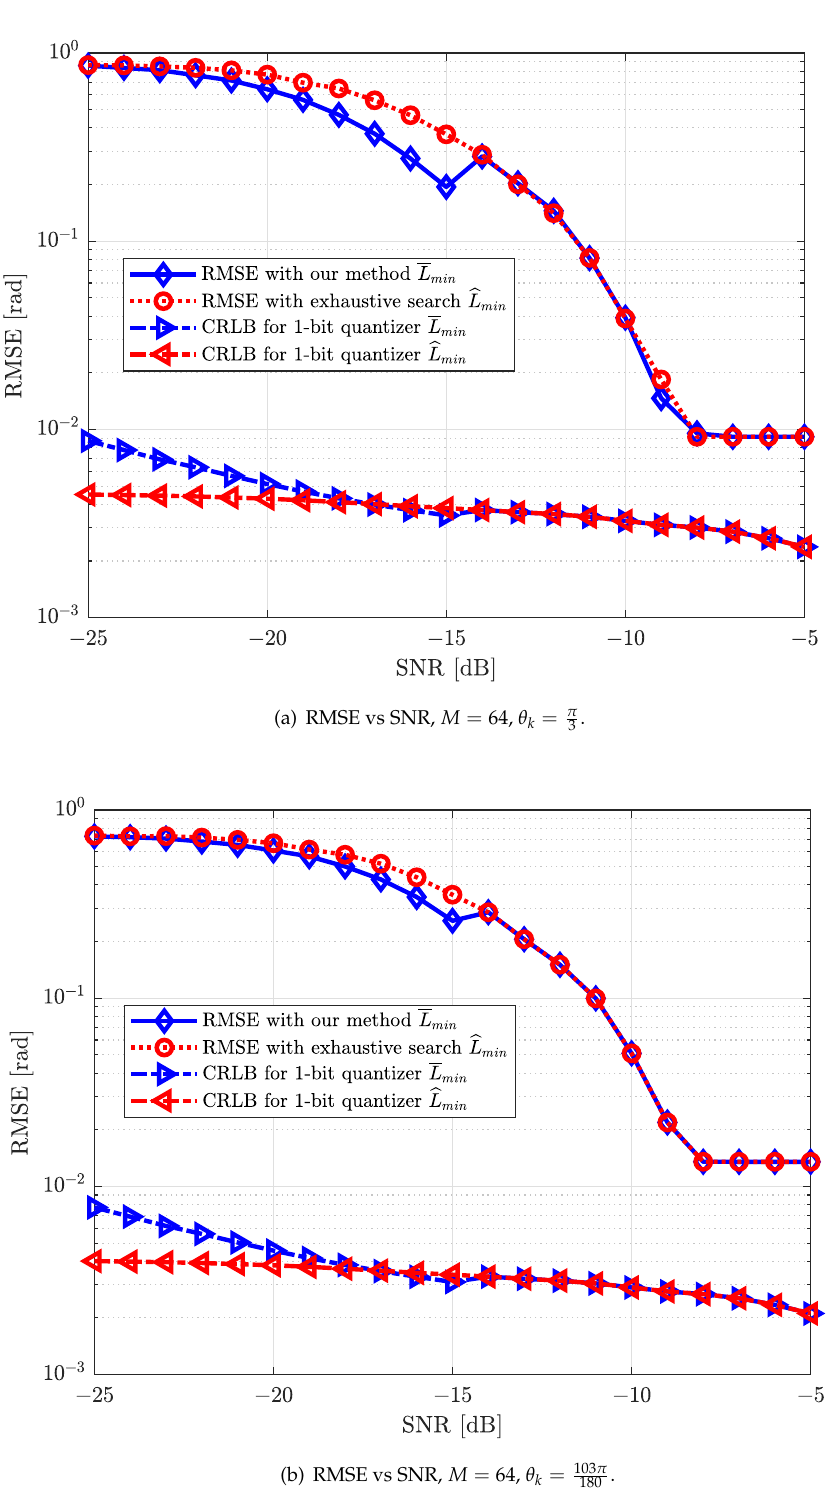
Figure 5. RMSE [rad] performance versus different SNRs [dB] for different